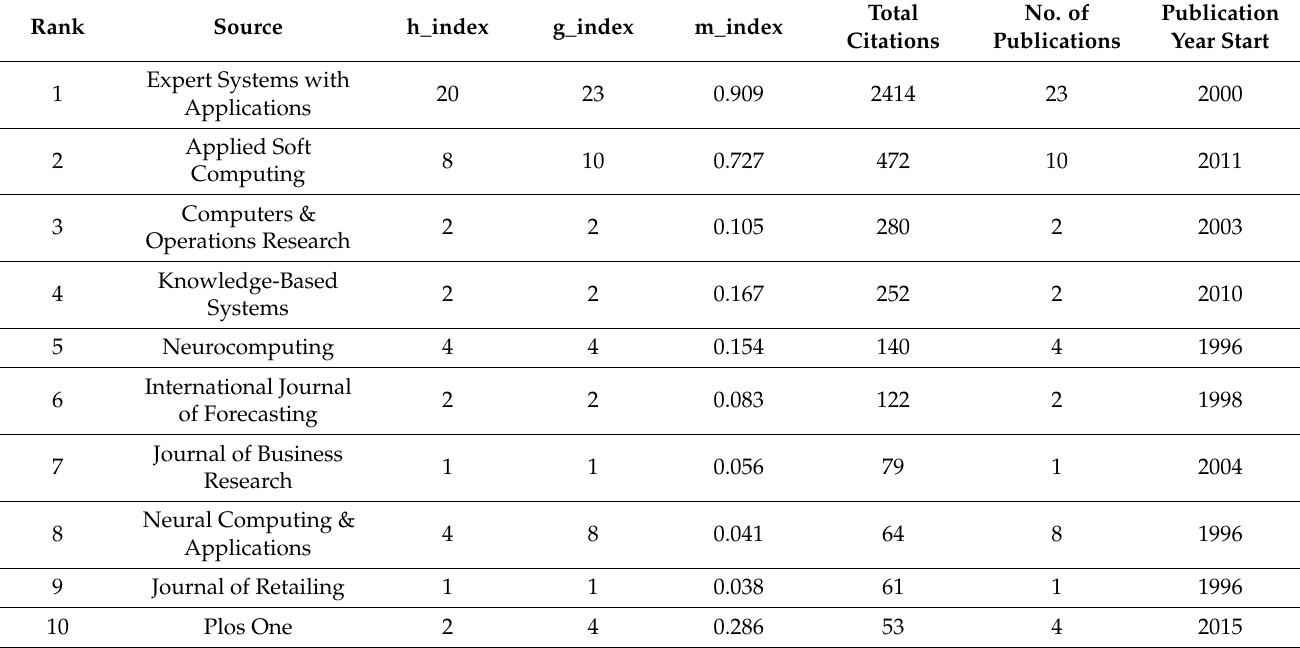
Table 5. Top 10 relevant